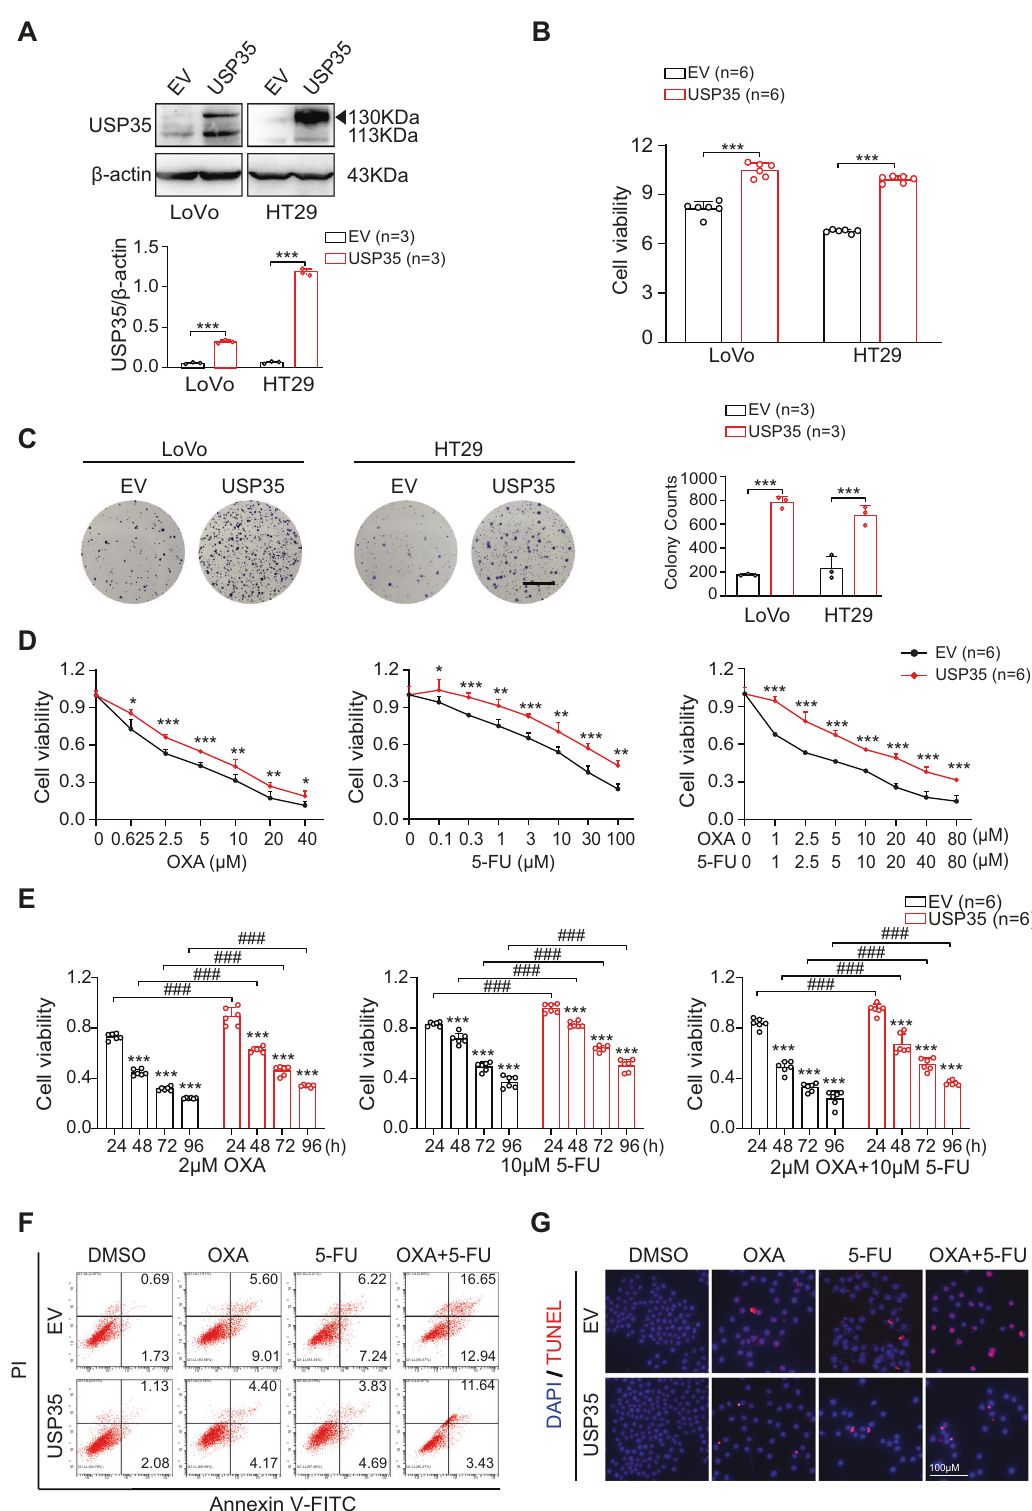
levels were increased in CRC patients (Figs. 1A, B and S1). We further examined USP35 protein expression in our CRC patient samples through immunohistochemistry (IHC) staining and western blotting (WB). Consistently, the USP35 expression was higher by approximately two folds in the cancerous